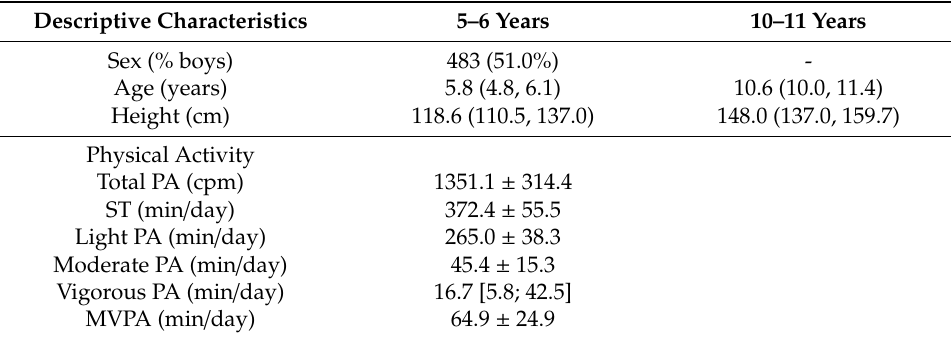
Table 1. Descriptive characteristics and physical activity behaviours of the children.